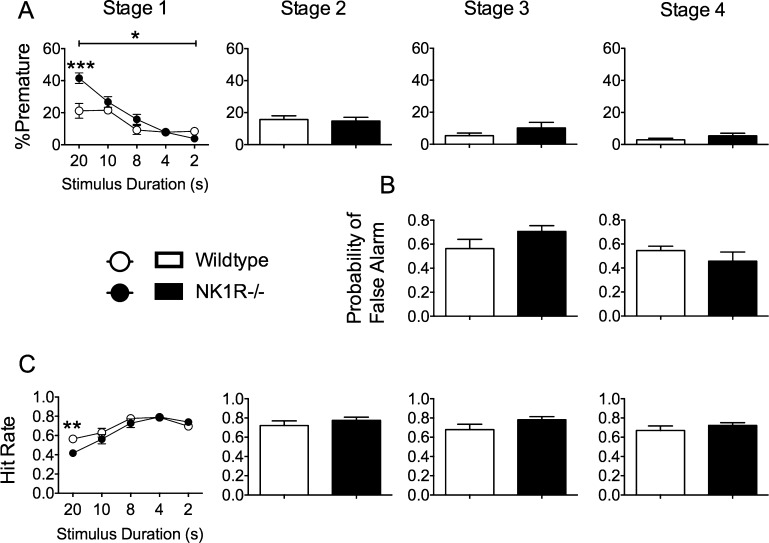
NK1R−/− mice carried out more premature responses and had a lower hit rate than wildtypes at the onset of training in Stage 1 of the 5C-CPT. Circles/bars show mean ± s.e.m. For Stages 2–4, the bars show data for the first day of training, only. A: % premature responses; B: probability of false alarms; and C: hit rate. Numbers on abscissae for Stage 1 specify the stimulus durations (gradually reduced from 20 to 2 s as animals achieved progression criteria). A line above graphs/bar charts indicates an overall difference between NK1R−/− and wildtype mice. Statistical significance of differences between pairs of data (compared by genotype) indicated by: *P < 0.05; **P < 0.01; ***P < 0.001. N = 12 per group.